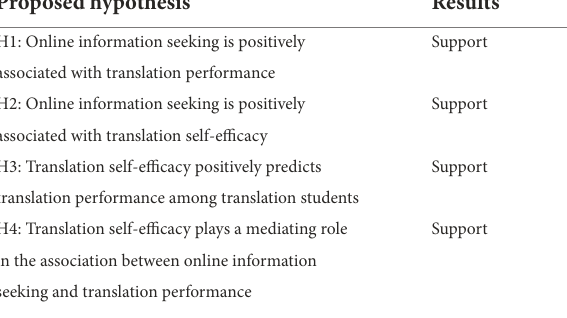
TABLE 5 Summary of the hypothesis